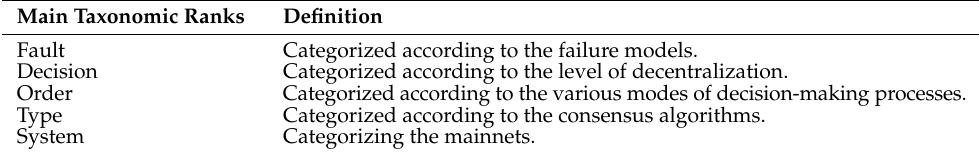
Table 6. A phylogeny approach: Defining the hierarchical taxonomy of consensus algorithms. Main Taxonomic